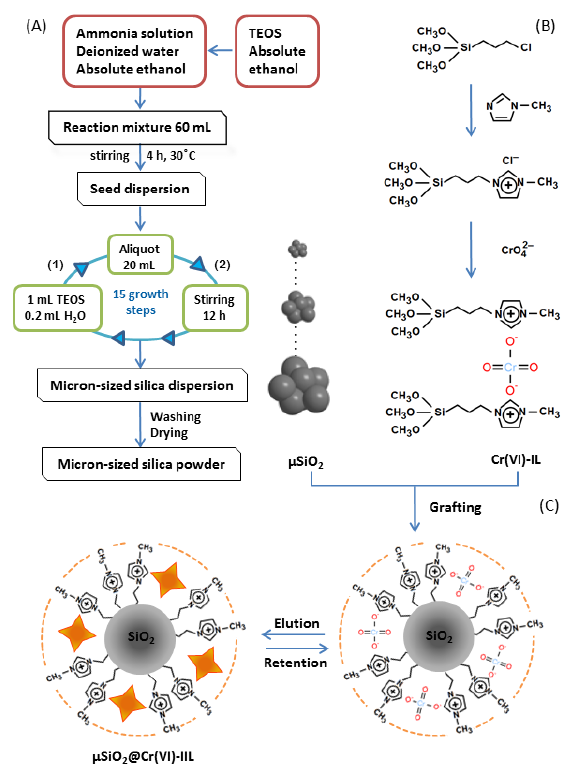
Figure 1: Schematic representation of (a) procedure for synthesis of micrometer-sized silica particles, (b) synthesis of ionic liquid and its coordination with chromate anion and (c) grafting Cr(VI)-IL complex onto SiO 2